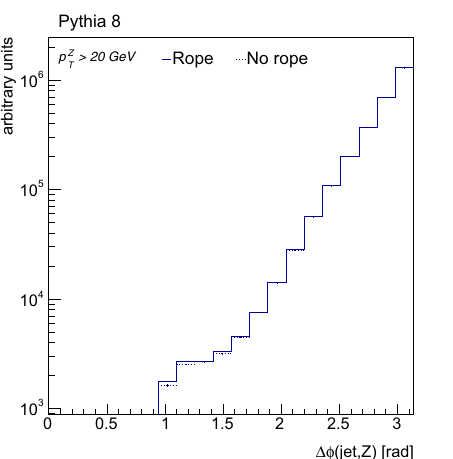
above threshold). Right: the multiplicity dependence of the azimuthal angle distribution. There is a slight broadening at higher multiplicities (on the left); this is not present for FM